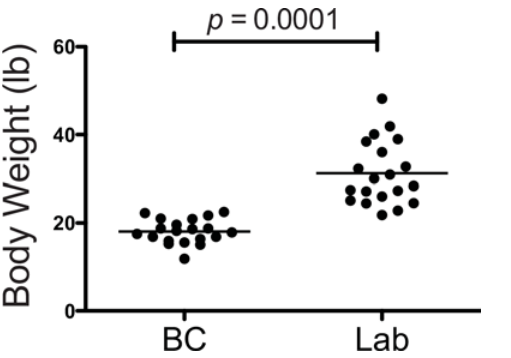
Fig 1. Body Weights of Border Collies and Labrador Retrievers. The Border Collies in this study weighed significantly less than the Labrador Retrievers.